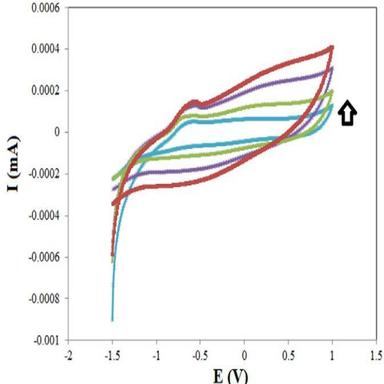
Cyclic voltammograms obtained by GO-imi- (CH2)2-NH2-CPE at different scan rate (100-400mv/s) in buffer solution.